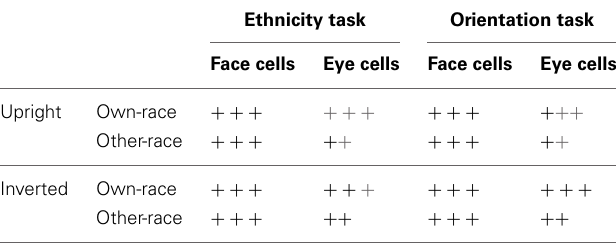
Table 3 | A potential mechanism for N170 ethnicity